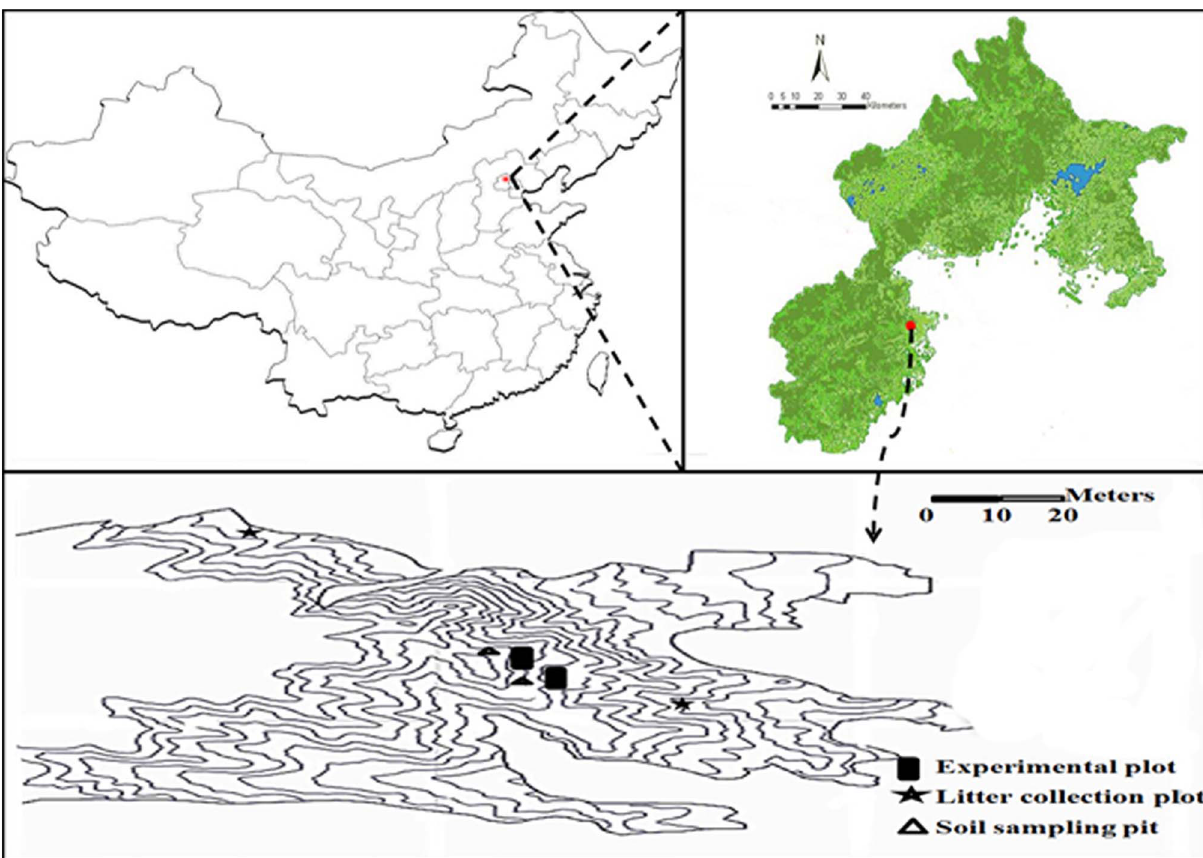
Figure 1. The location of the study area.